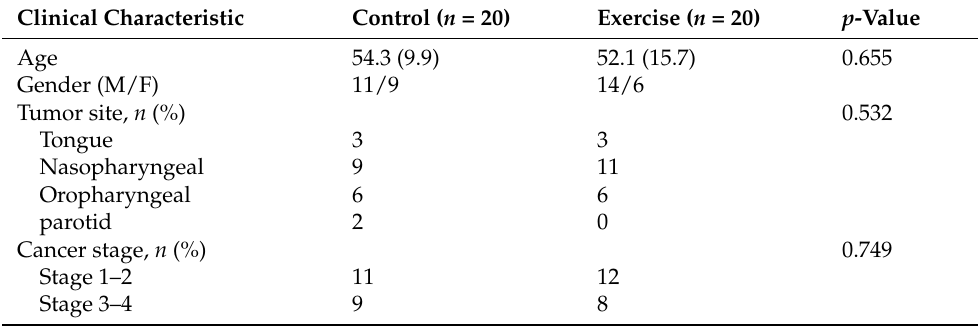
Table 1. Demographic and medical characteristics of the exercise group and control group.